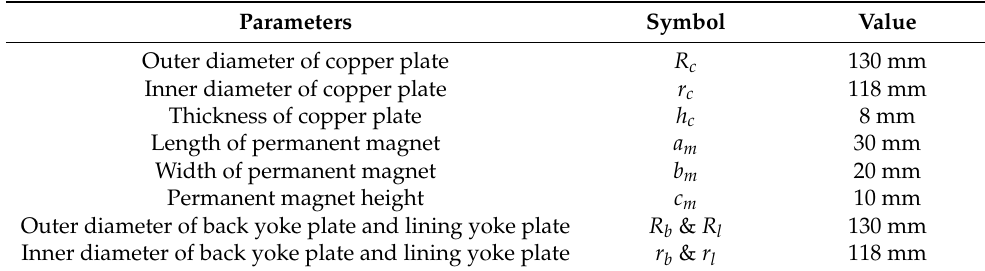
Table 1. Structural parameters of permanent magnet coupling.